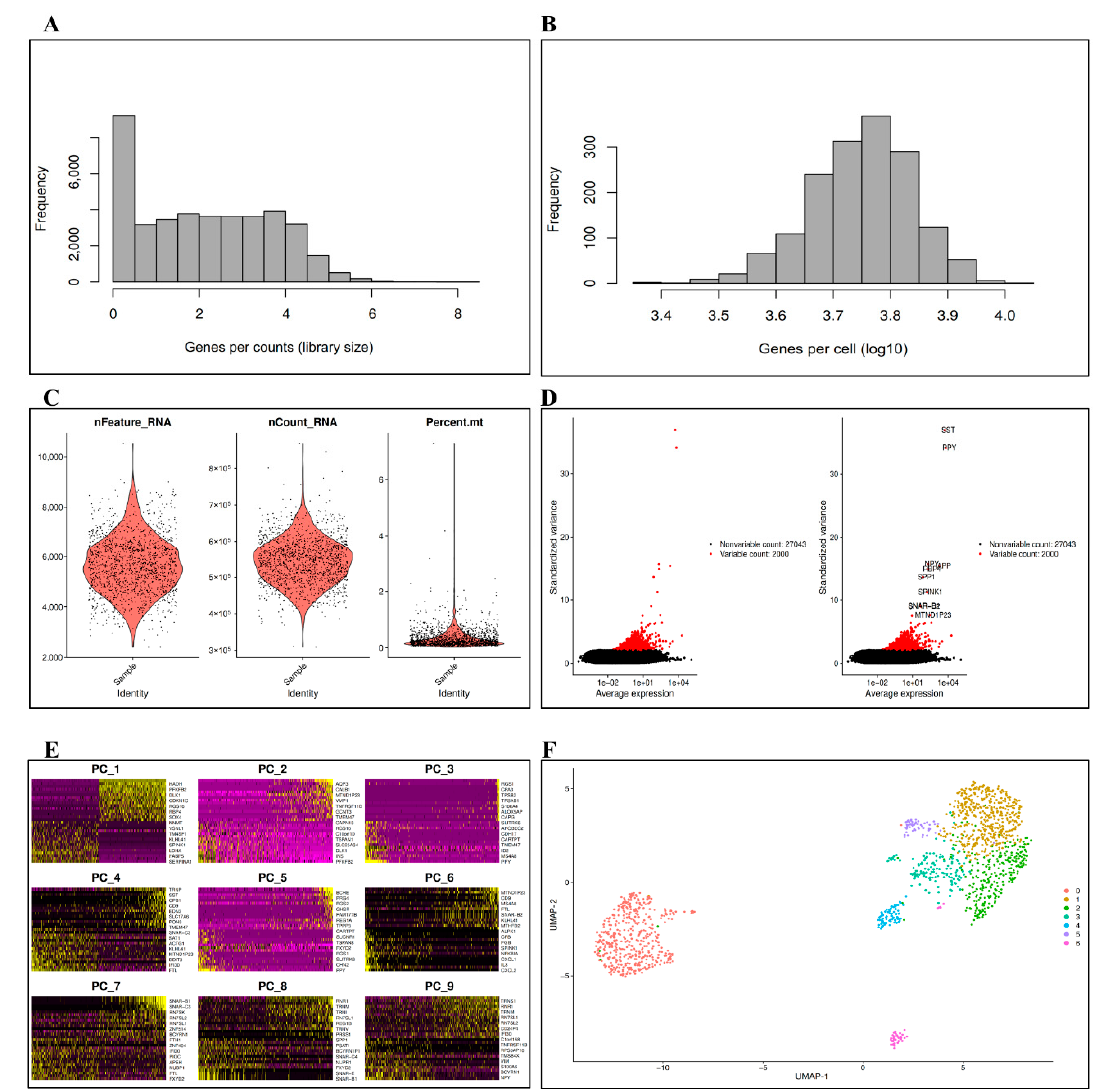
Figure 2. Preprocessing of scRNA-seq data. ( A ) Measurement of library size for genes per counts; ( B ) Genes distributions among cells; ( C ) Quality control; ( D ) Variable genes in the dataset; ( E ) Dimensionality reduction heatmap PCA; ( F ) UMAP clustering of the dataset.